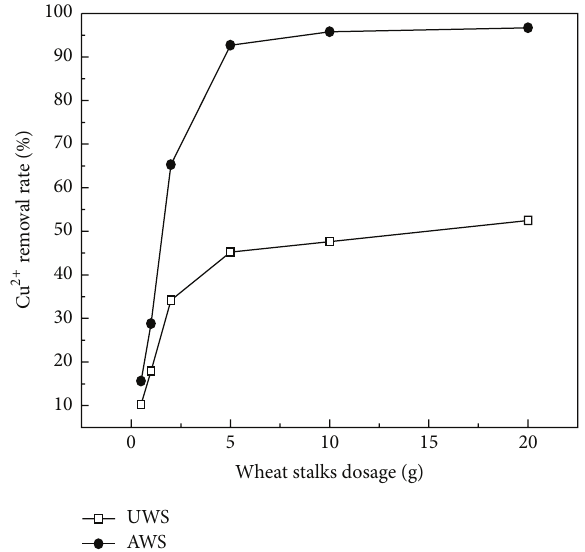
Figure 3: Effect of wheat stalks dosage (conditions: adsorbate conc. = 20 mg/L, pH = 5, contact time = 6 h, temp. = 25 ± 1 ∘ C, and stirring rate =